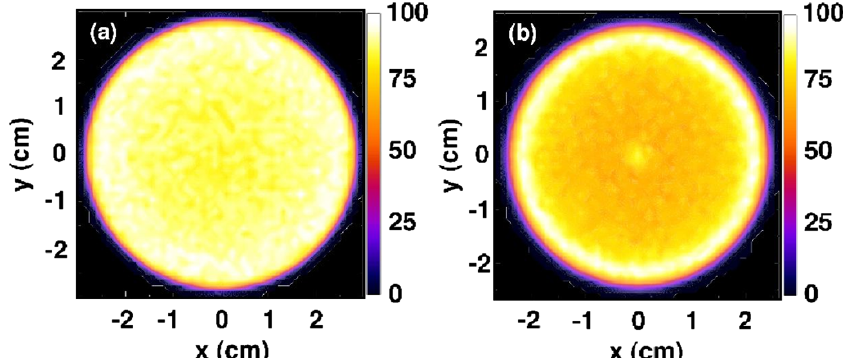
FIG. 5. (Color) Transverse beam distribution calculated at the scintillator plane ( z (cid:6) 43 cm ): (a) ideally with no emitter gap; (b) with the emitter surface recessed 22 mils back from the knife edge of the Pierce cone (no focusing with solenoids; note scale differences).